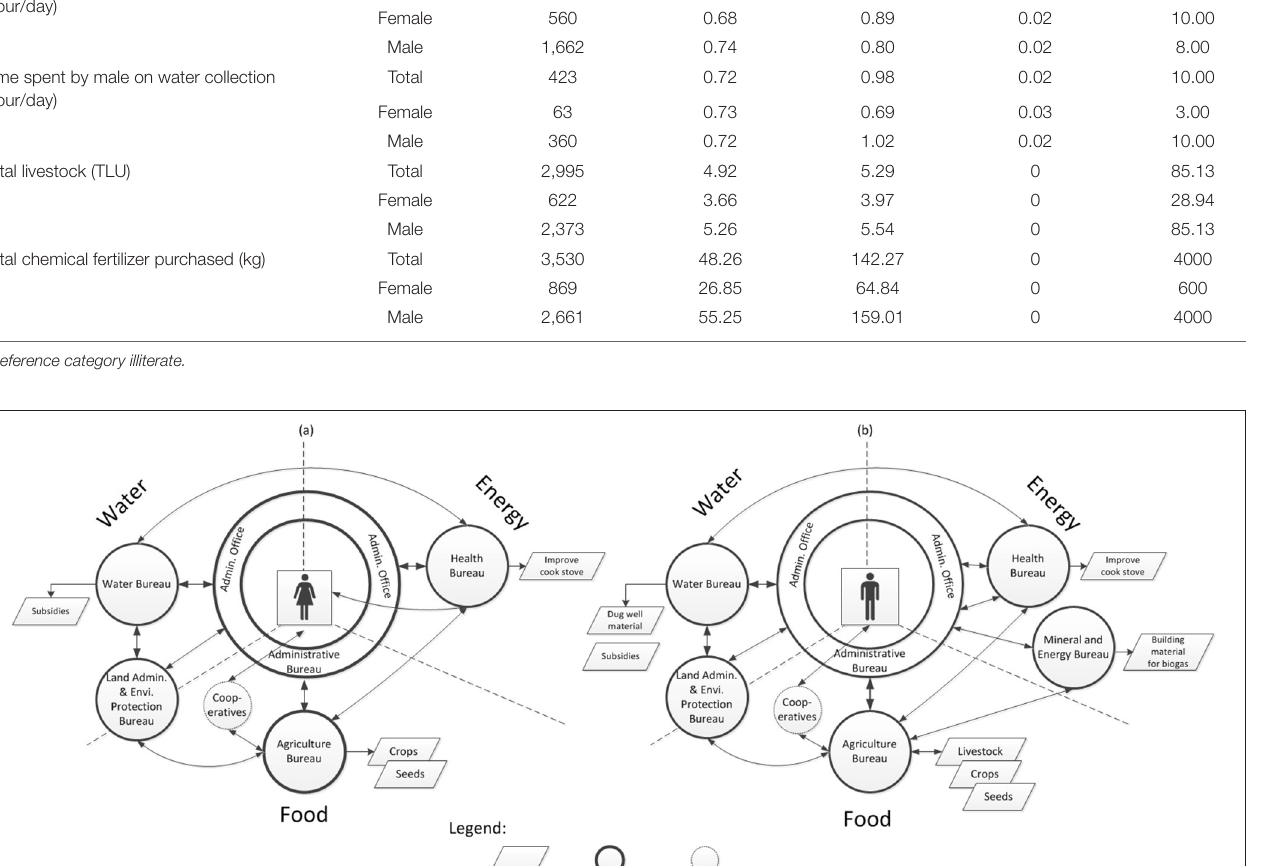
fertility for household vegetable production. According to the workshop participants, the use of dung reduces fertilizer costs by 650 ETB ha − 1 . Due to the scarcity of raw material (i.e., limited number of cattle), the amount of dung used for soil fertility treatment per household is minimal; hence, it is only applied for